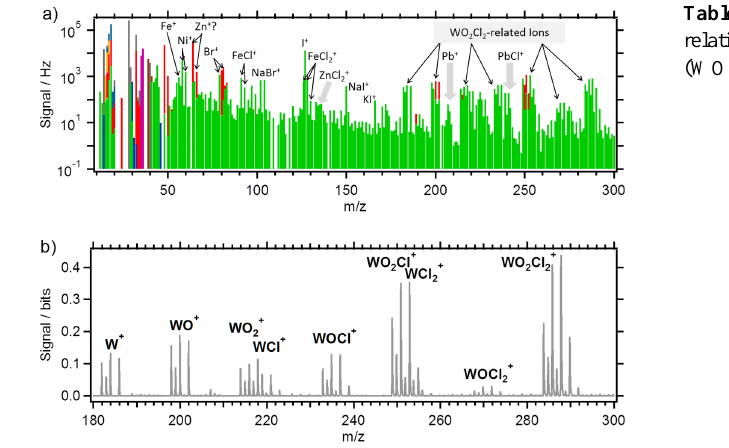
Figure 6. (a) One-minute average unit-mass resolution spectrum from a measurement of the exhaust aerosol of a municipal waste incinerator (ammonium: orange; nitrate: blue; sulfate: red; chloride: purple; organics: green; PAH: also red; association of ion signals from the standard frag table). (b) Cutout of the high-resolution mass spectrum of (a) showing the WO 2 Cl 2 -related ion signals.